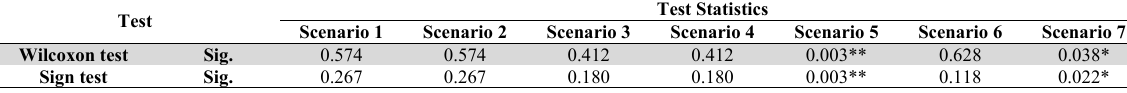
Test results of the differences among the DEA models orientation